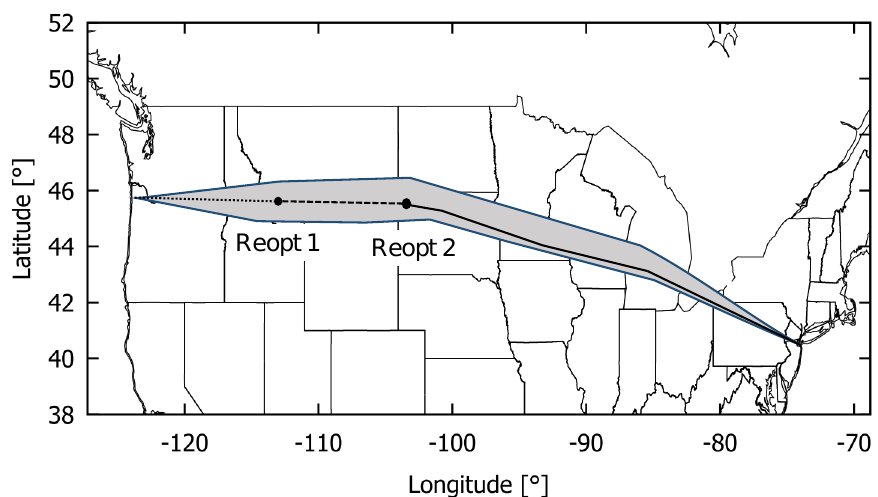
Figure 8. CoO solution space (grey) with two re-optimizations of the trajectory during flight (Reopt 1, Reopt 2). Different line types represent the best flight path after each re-optimization. The blue line shows the additional buffer enveloping the